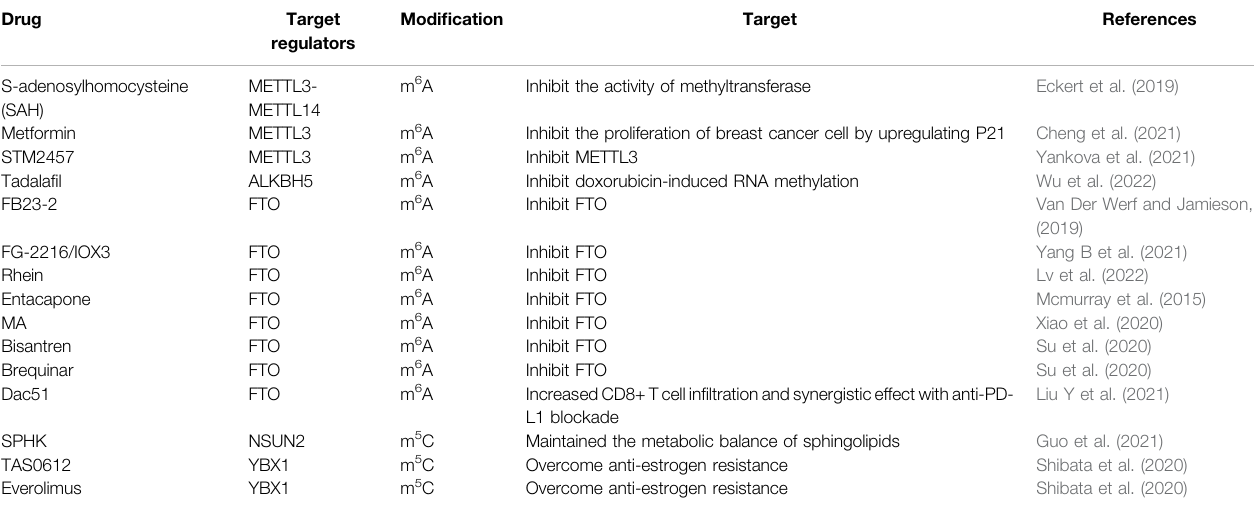
TABLE 2 | The potential drugs applied in the treatment of breast cancer based on the RNA modi fi cation.